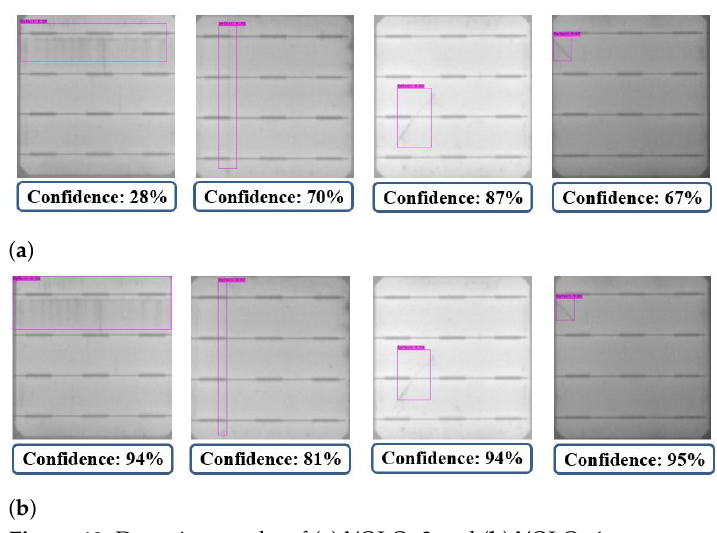
Figure 18. Detection results of ( a ) YOLOv3 and ( b )